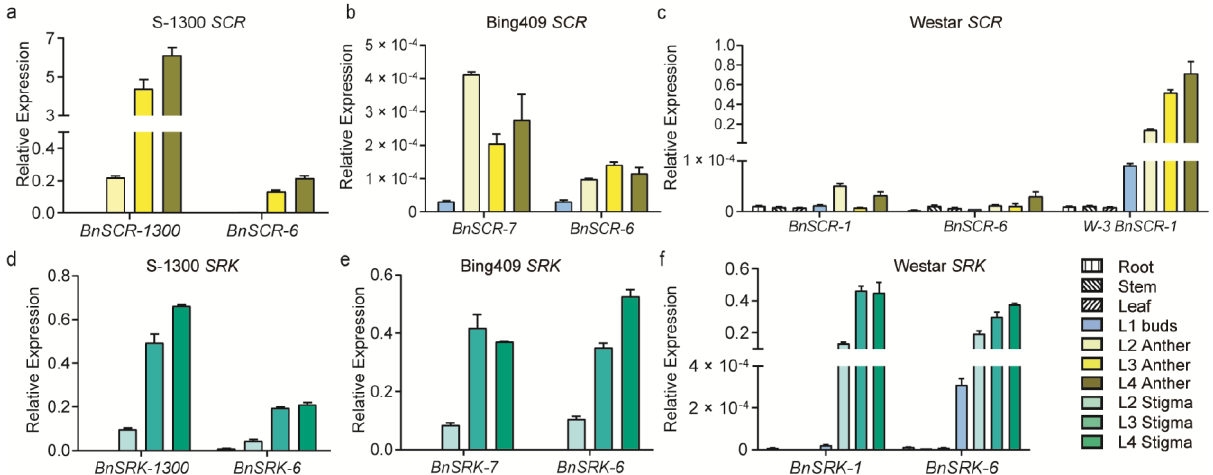
Figure 2. Relative expression of SCR and SRK in different tissues of B. napus . ( a – c ) Relative expression of SCR in different tissues of ‘ S-1300 ’ , ‘ Bing409 ’ , ‘ Westar ’ , and ‘ W-3 ’ , respectively; ( d – f ) Relative expression of SRK in different tissues of ‘ S-1300 ’ , ‘ Bing409 ’ , and ‘ Westar ’ , respectively. The relative expression was corrected using the reference gene BnActin7 .